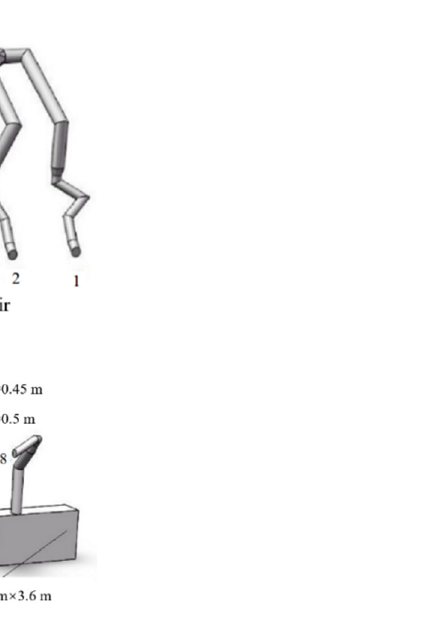
Figure 2. Secondary air box and branch pipe on the part side of the furnace. ( number 1 to 8 are pipes numbers).